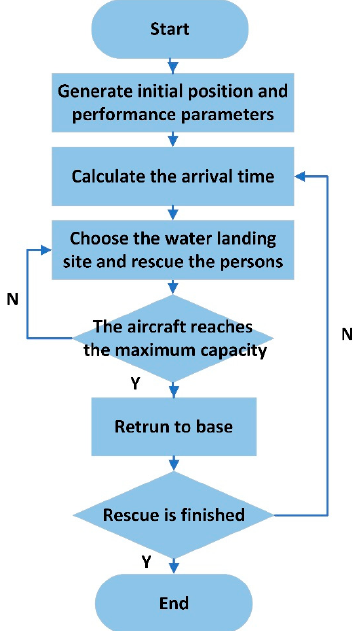
Figure 11. The behavior model of the amphibious aircraft agent.